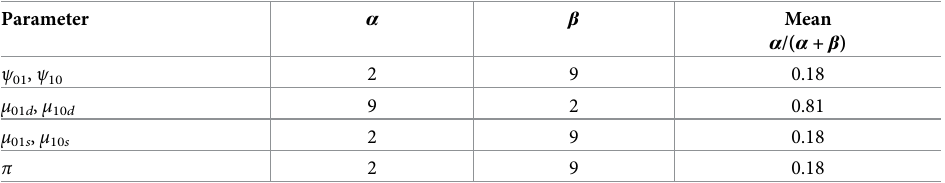
Table 3. Parameters for the beta priors used in MCMC and MAP estimation. Shape parameters ( α , β ) were set with the prior that functional gain and loss, ( μ 01 d , μ 10 d ), are more likely at duplication events.